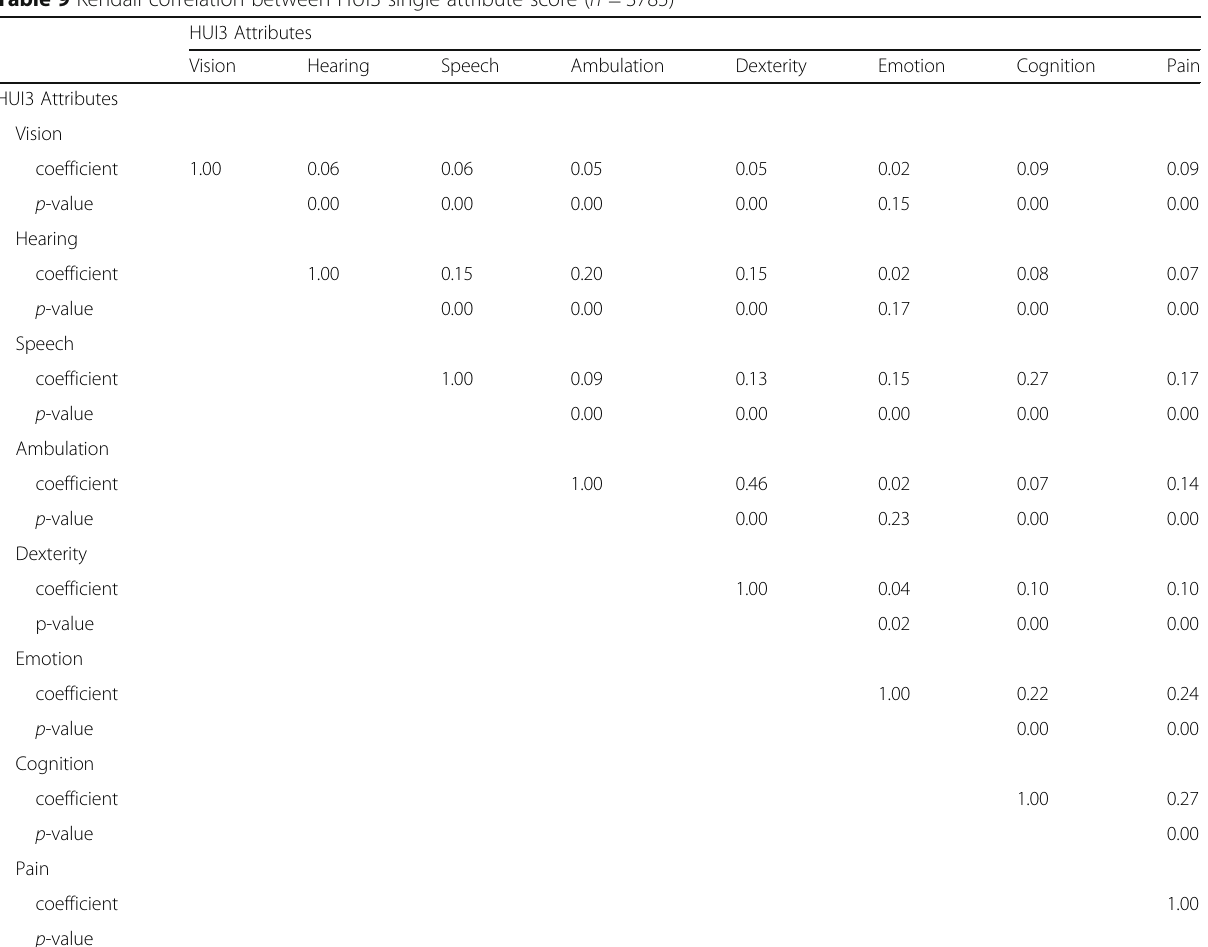
Table 9 Kendall correlation between HUI3 single attribute score ( n = 3785) HUI3